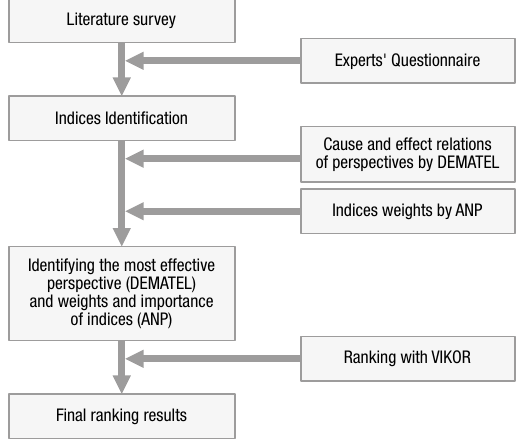
Fig. 1. Performance evaluation framework of